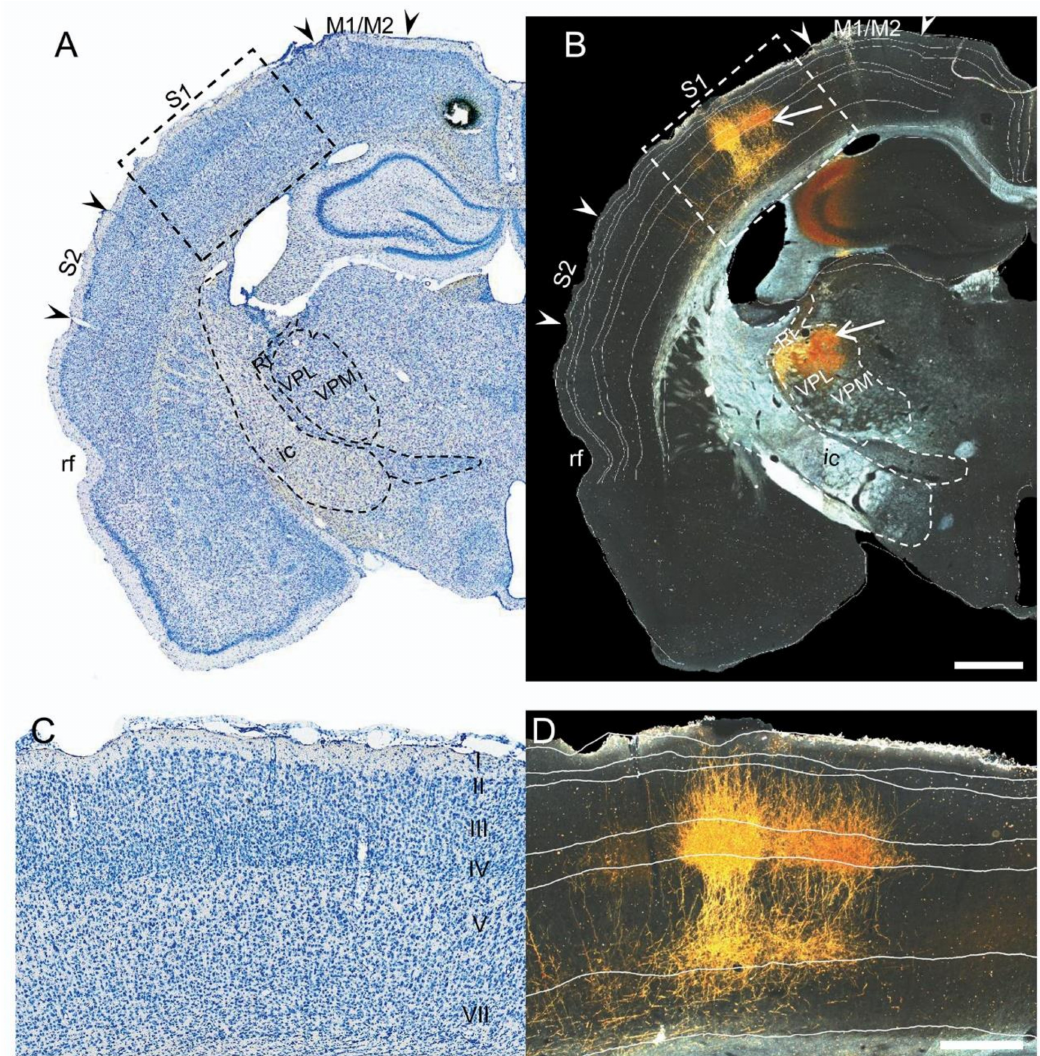
Figure 4. Brightfield and darkfield photomicrographs of a thionin-stained ( left ) and PHA-L immunolabeled ( right ) sections of a naïve rat. ( A ) Thionin-stained section of a left hemisphere ipsilateral to thalamic PHA-L injection. The PHA-L injection was targeted to the thalamic ventral posterolateral (VPL) and ventral posteromedial (VPM) nuclei. ( B ) A darkfield image of the rat left hemisphere with PHA-L immunoreactivity (ir). PHA-L-ir in the thalamus is observed in the VPL and VPM thalamic nuclei (open arrow). The efferent terminals from the VPL and VPM innervated the primary somatosensory cortex. ( C ) High magnification of the area within the dashed line in panel A depicting the cortical layers. ( D ) High magnification of the area within the dashed line in panel B, depicting the laminar distribution of the axonal terminals. Note the dense axonal plexus in layer IV and the border between layers V and VI. Collaterals traveled through layers II/ III into layer I. Scale bar in A and B equals 1 mm, and in C and D equals 400 µ